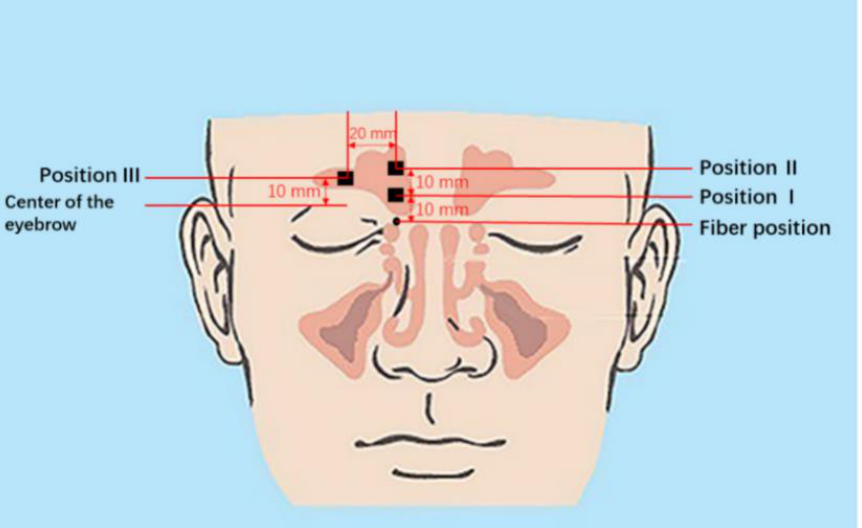
Figure 2. Location sites of the light emitting fiber and the detector. The size of the detector is 10 × 10 mm 2 and positions relate to the center of the detector. Anatomy figure adapted from [9].